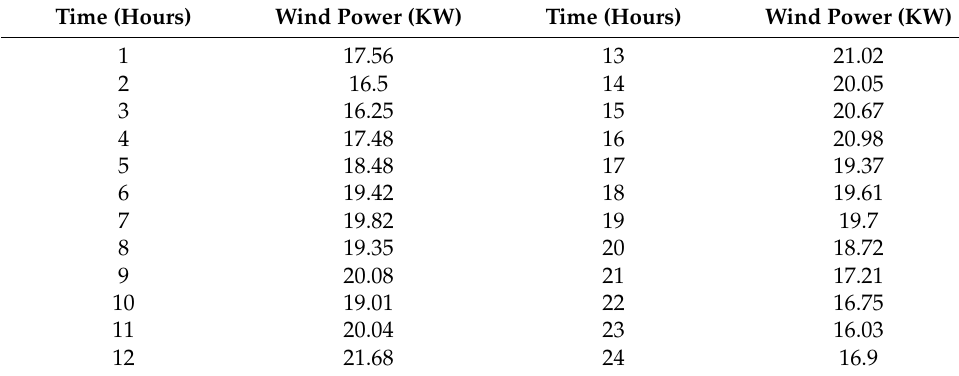
Table 2. WG Power prediction